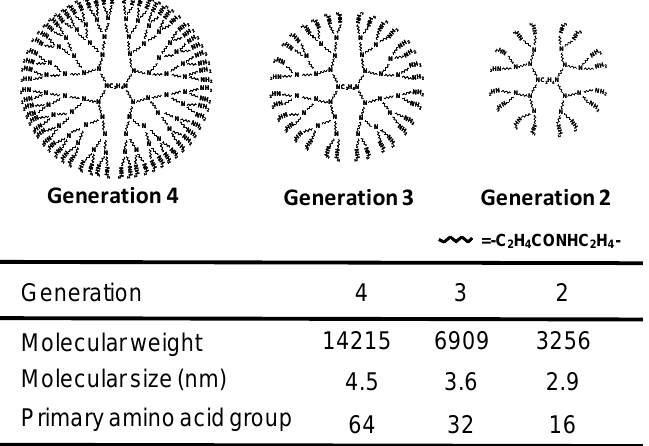
Figure 1. Chemical structures of PAMAM Dendrimers (G4, G3,